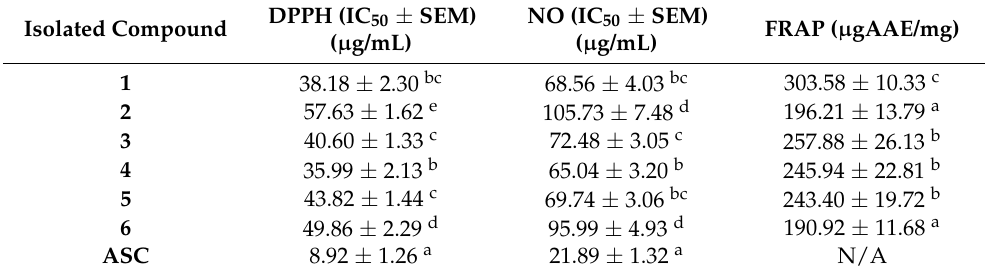
Table 5. Antioxidant Activities of Isolated Compounds from Cyperus sexangularis Leaf. DPPH (IC 50 ± SEM) NO (IC 50 ± SEM) Isolated Compound ( µ g/mL) ( µ